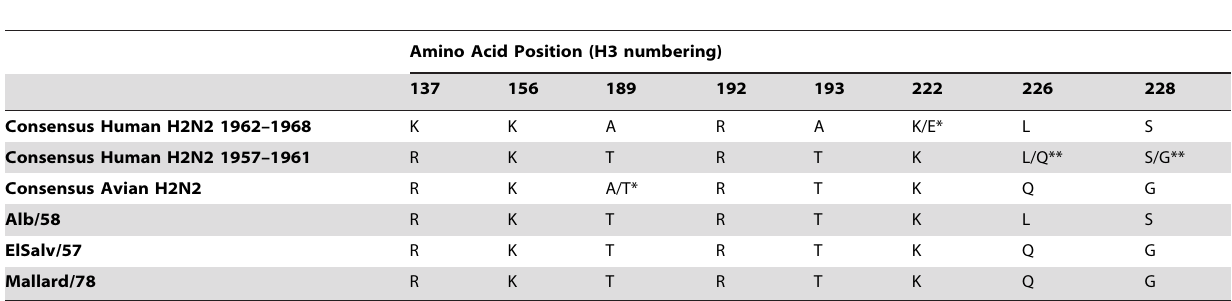
Table 3. Composition of the hemagglutinin receptor binding amino acids and residues that interact with a 2-3 and a 2-6 glycans.